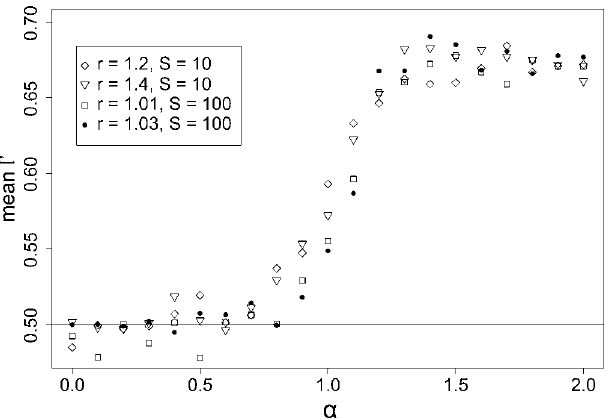
Figure 2. The Effect of Population Expansion and Fertility Inheritance on the Balance Measure Mean I 9 For each value of the fertility inheritance parameter a and each scenario of population expansion, 100 coalescent trees with 100 individuals were simulated. Each point corresponds to the mean value of the mean I 9 for the 100 replicates. The parameter r denotes the geometric rate of the population expansion and S denotes the time, measured in generations, since the beginning of the expansion.